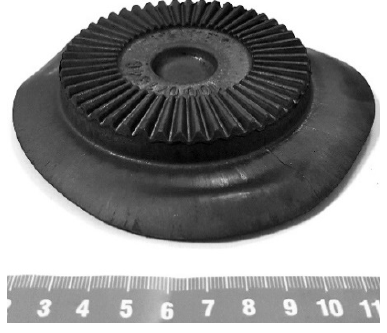
Figure 9. Drop forged gear wheel. Materials 2020 , 13 , x FOR PEER REVIEW